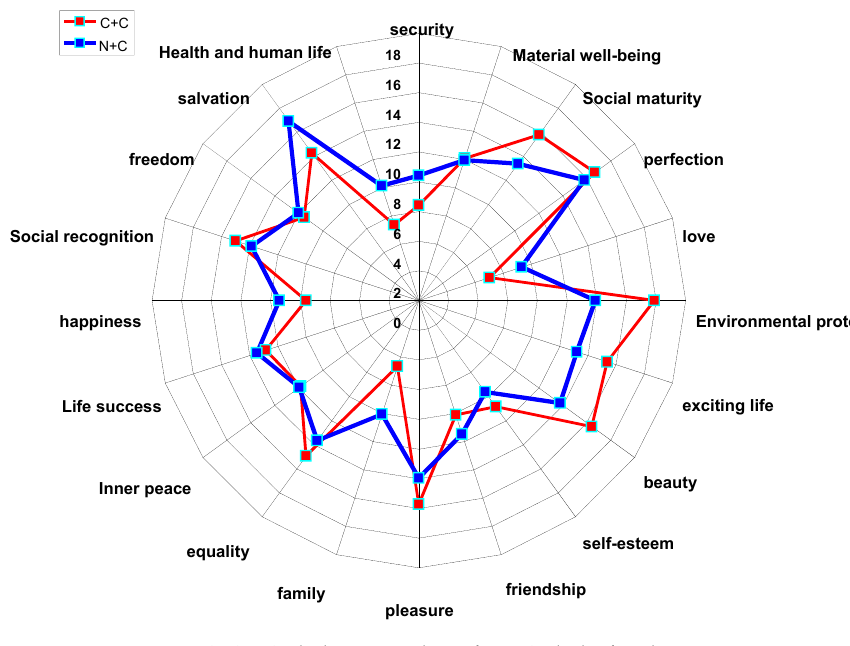
Figure 5. Statement of the terminal value preferences of Catholic respondents and respondents not declaring religion from Catholic families. Source: own study based on research results.